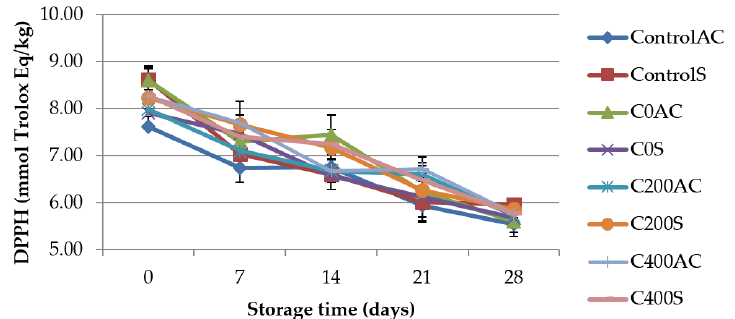
Figure 8. TAC value using DPPH as the antioxidant probe in sausage samples covered with sodium alginate coatings.